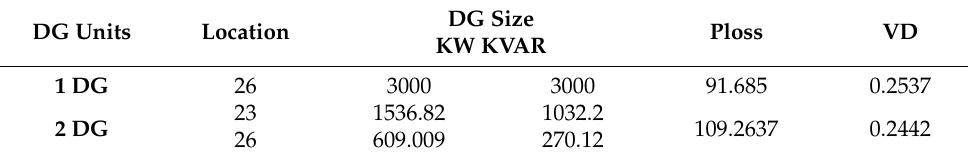
Table 18. Case 5: optimal DG III allocation based on voltage deviation.